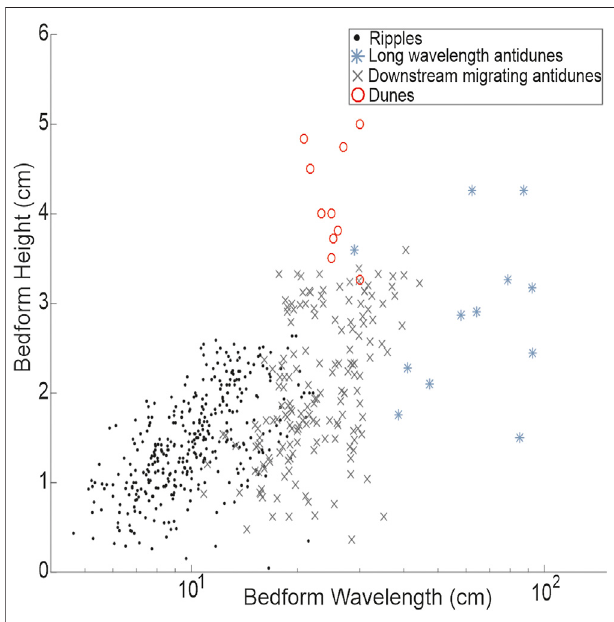
FIGURE 7 | Bedform dimensions (data from all